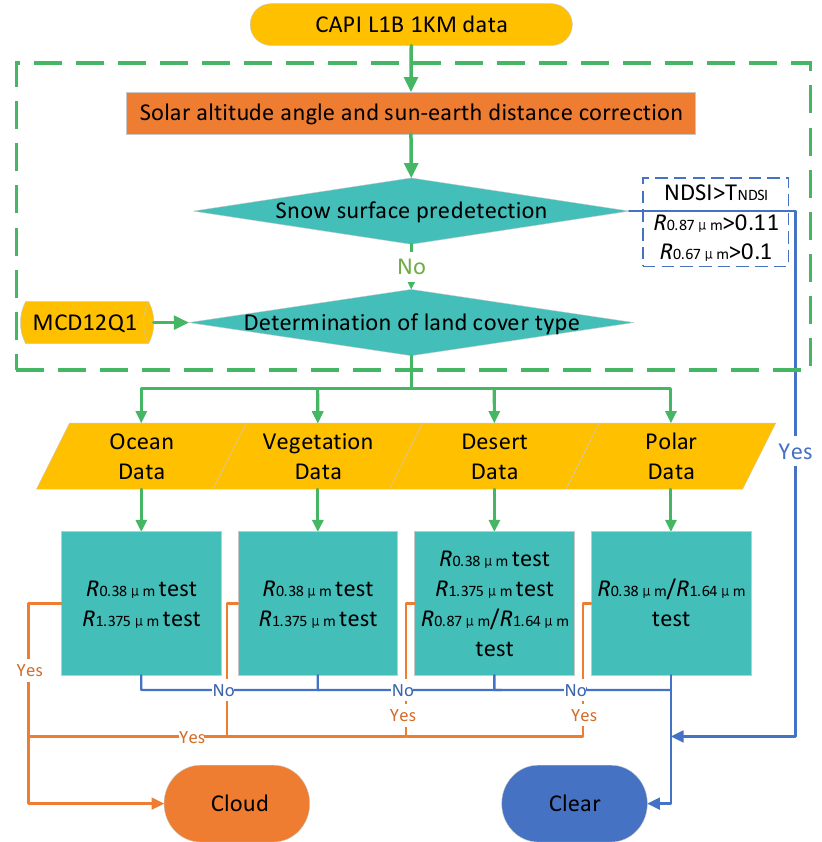
Figure 3. Flow chart of NNDT algorithm using CAPI data.